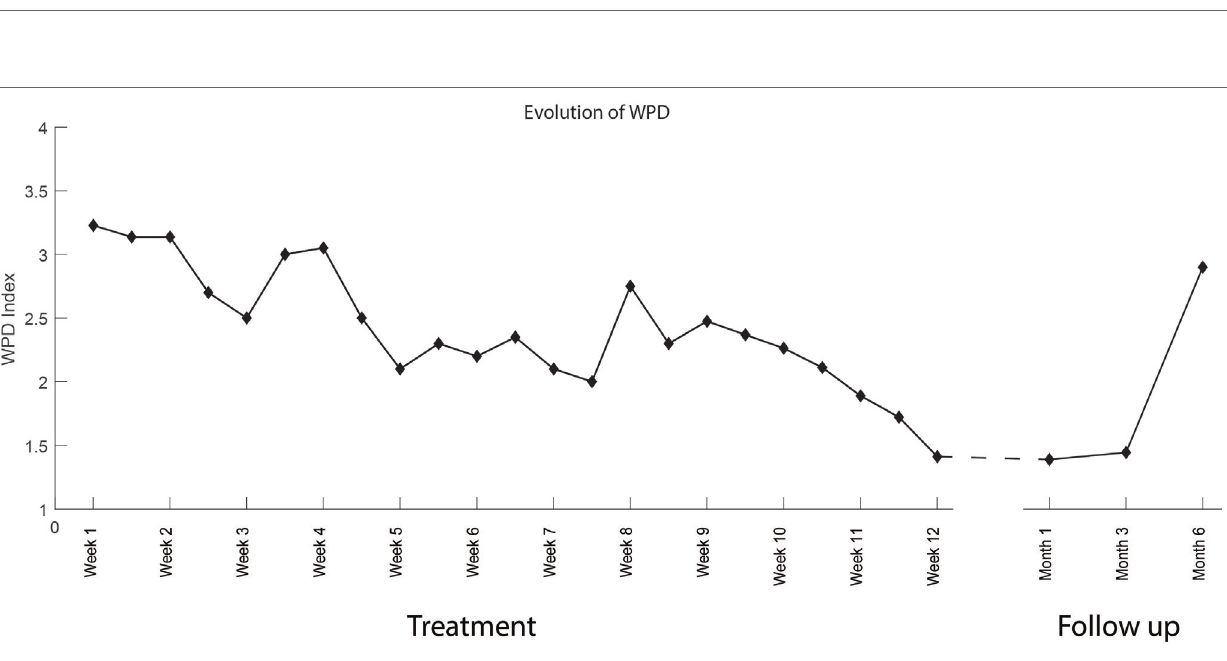
FigUre 8 | Graph representing the value of the Weighted Pain Distribution (WPD) throughout the 23 treatment sessions and at 1, 3 and 6-month follow-up (right hand side of the dashed line). The WPD is calculated as the sum of the scores (0–5) weighted on the total time spent awake.